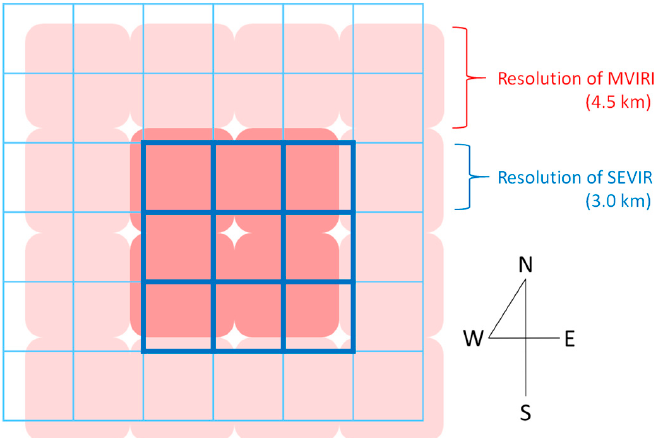
Figure 10. Schematic of the MVIRI (2 × 2 red boxes) and SEVIRI (3 × 3 boxes with blue borders) pixel averages used for the comparison.